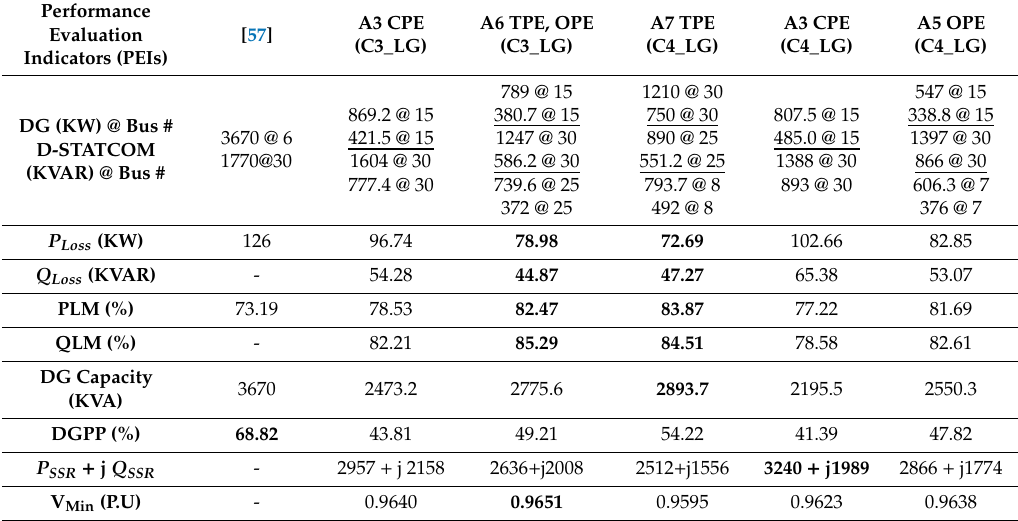
Table 35. Comparisons of results with C3_LG and C4_LG for 33-bus TDN (REG +